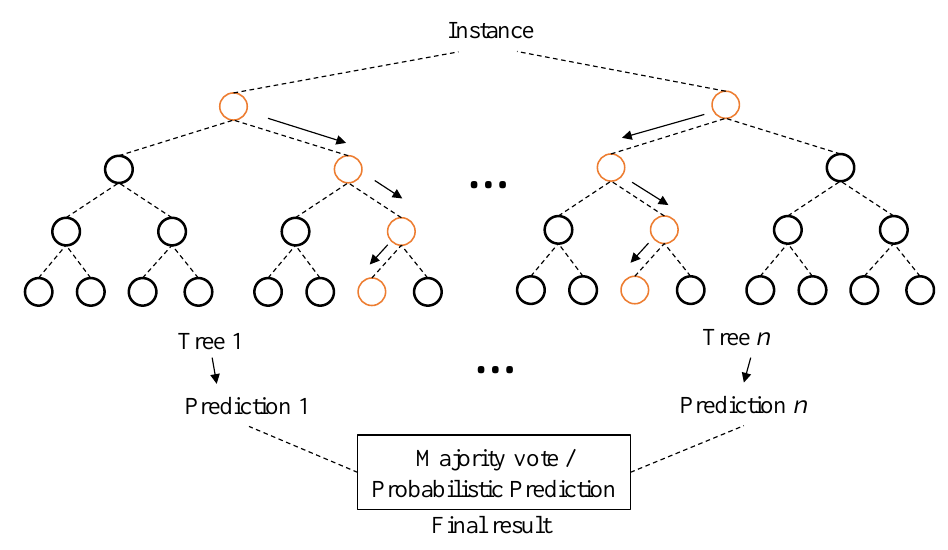
Figure 2. Illustration of a random forest (RF) model .